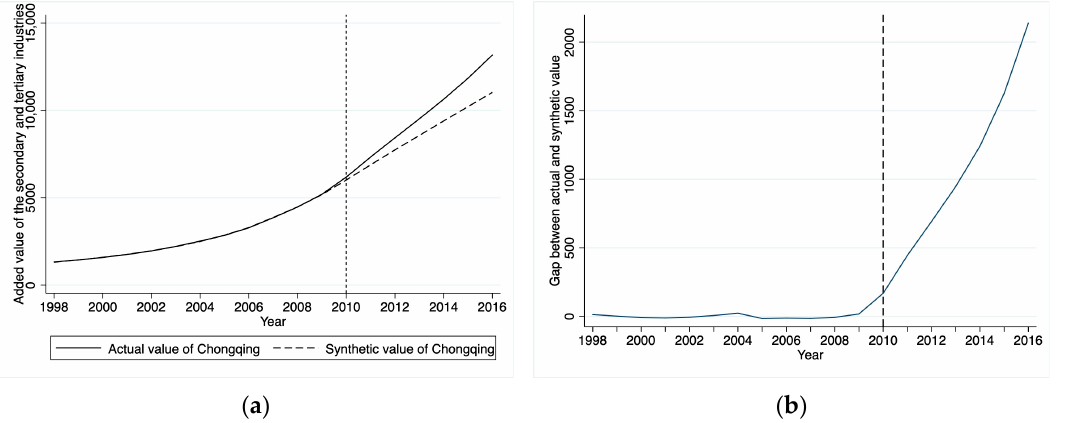
Figure 6. Results of synthetic control analysis: ( a ) actual value V.S. synthetic value; ( b ) gap between actual and synthetic value.